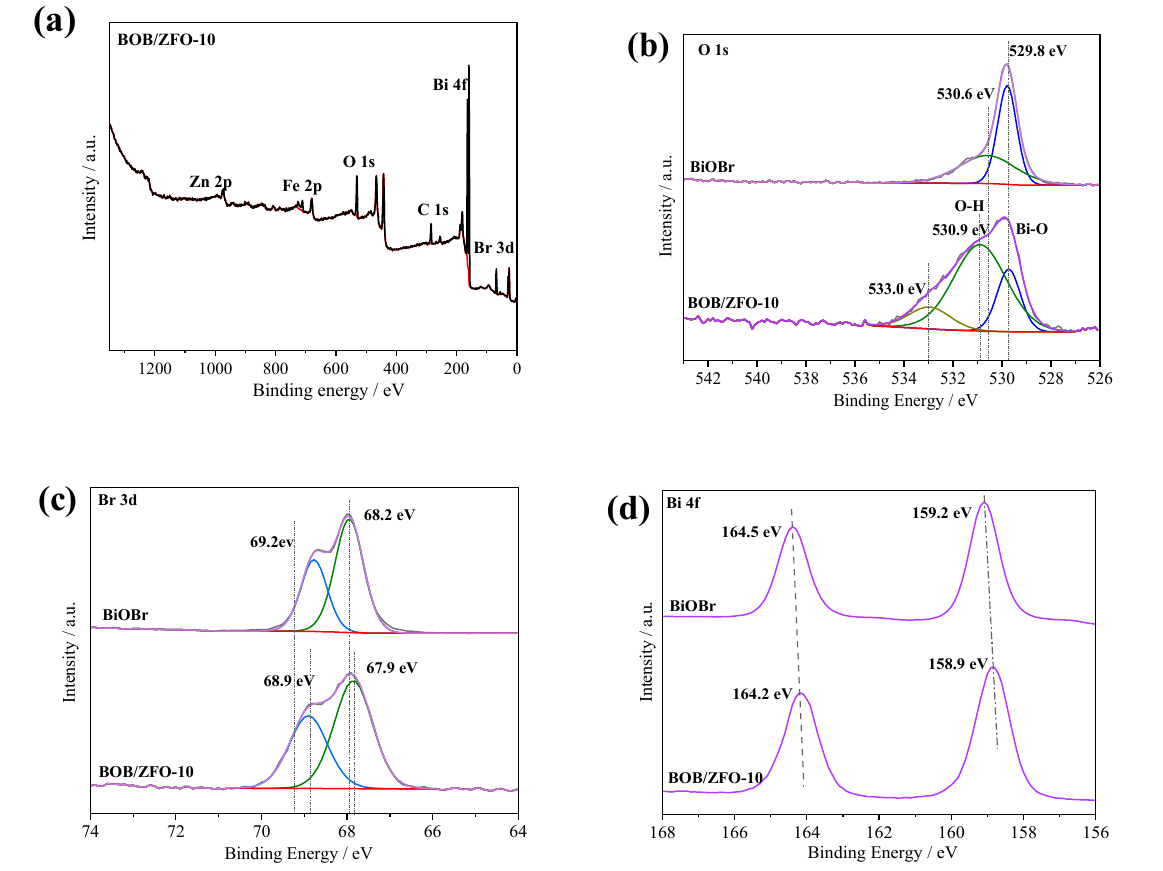
Figure 5. ( a ) XPS full spectrum of BOB/ZFO, BiOBr with ( b ) O1s, ( c ) Br3d, ( d ) Bi4f XPS spectrum of BOB/ZFO–10.